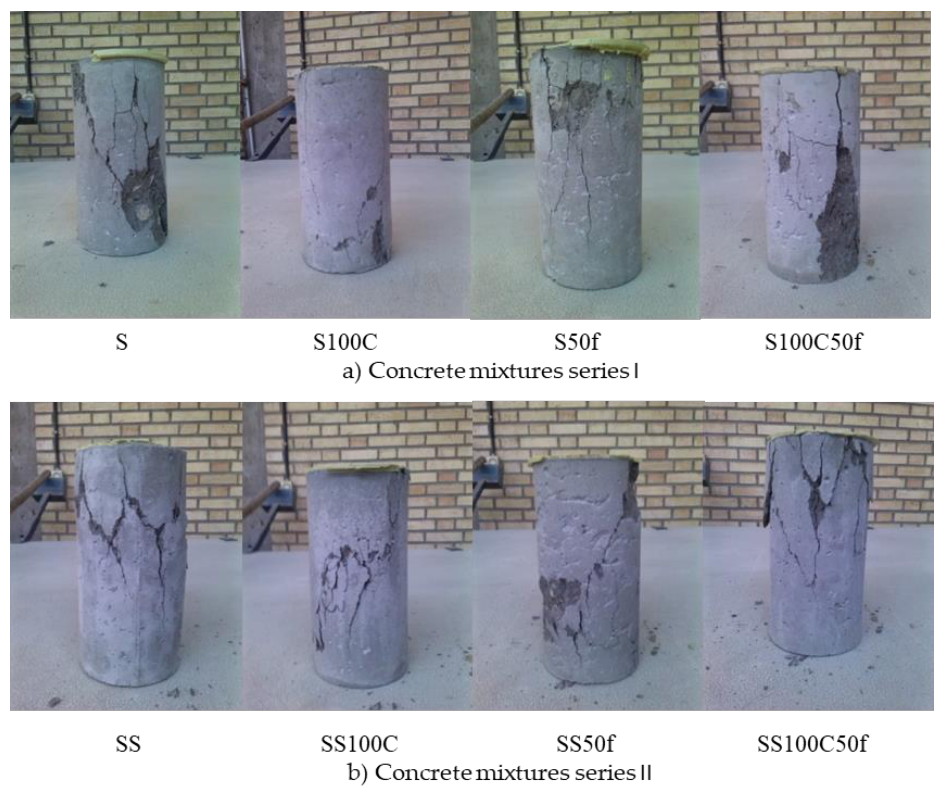
Figure 12. Failure pattern of mixtures in compressive stress, ( a ) Series I and ( b ) Series II.